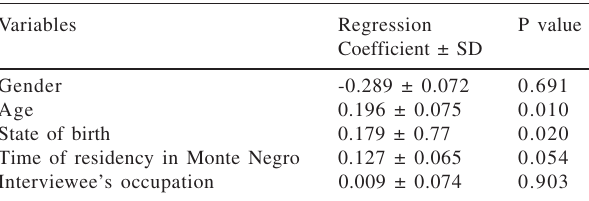
Table 5 - Multivariate analysis for variables associated with Anti-HBc prevalence.